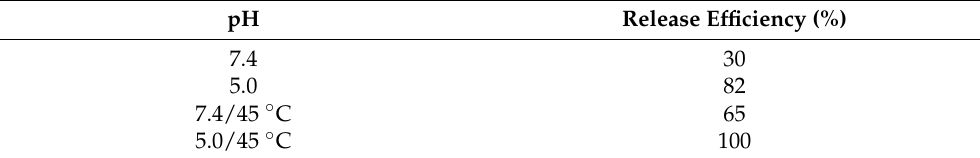
Table 3. Various PNIPAM-based copolymer hydrogels for Cur delivery. Table 2. Cur release efficiency from PNIPAm-co-PAAm-Mel HG system at pH/temperatures. Polymers Stimuli